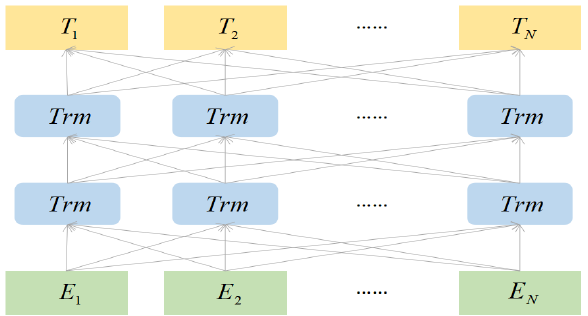
Figure 1. The structure of BERT using the structure of bidirectional transformer [37].